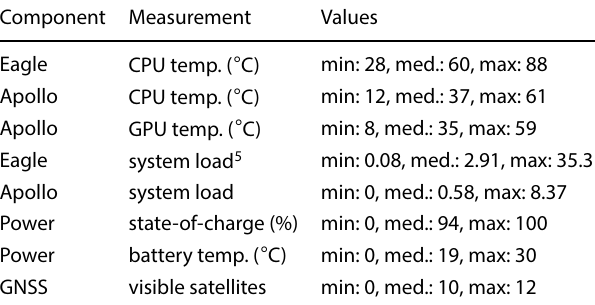
Table 3 System health values during the operation Component Measurement